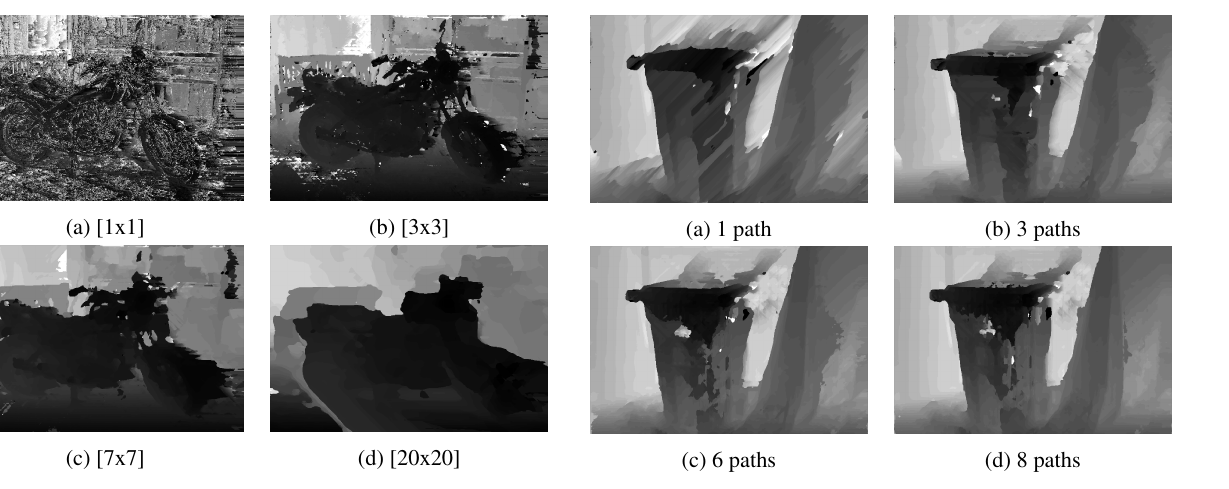
Figure 4. mdaSGM: influence of sum aggregation block size Figure 5. mdaSGM: influence of path